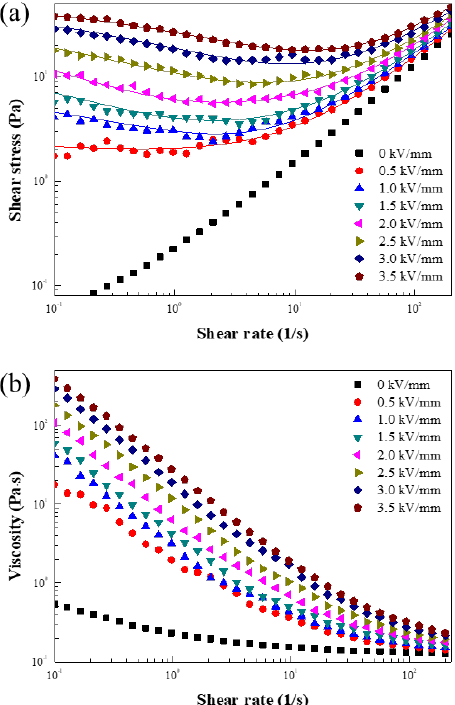
. Figure 7. Shear stress ( a ) and shear viscosity ( b ) as a function of 𝛾̇ for the ER fluid under the E from Figure 7. Shear stress ( a ) and shear viscosity ( b ) as a function of γ for the ER fluid under the E from 0 0 to 3.5 kV/mm (the solid lines in ( a ) are fitted using the CCJ equation) to 3.5 kV/mm (the solid lines in ( a ) are fitted using the CCJ Table 1. Parameters of the CCJ equation fitting deduced from ZnFe 2 O 4 /PMA − based ER fluid. Electric Field Strength (kV/mm) Model Parameters